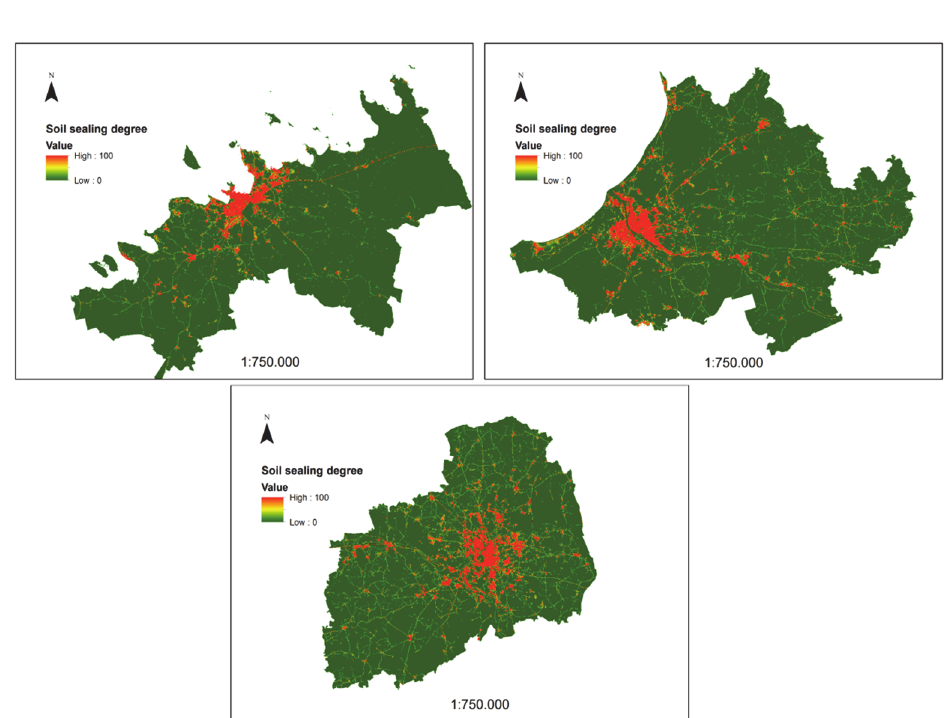
Fig. 4. Degree of soil sealing of Tallinn (top left), Riga (top right) and Vilnius (bottom) FUAs (data source: